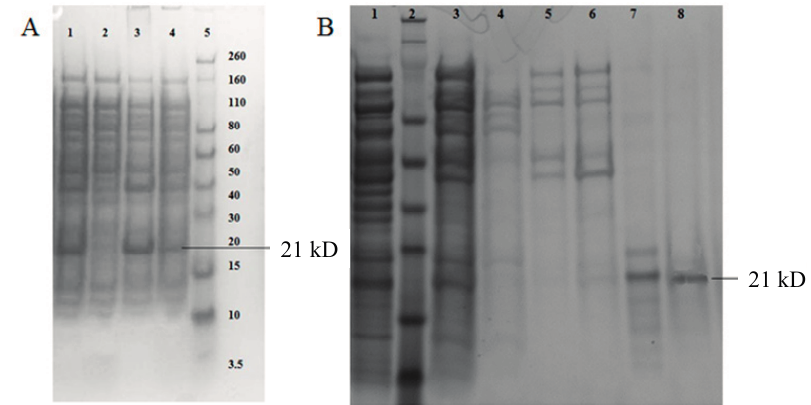
Figure 3. Expression, solubility and purification profile of hybrid HBcAg VLP. ( A ) Expression and solubility profile of hybrid HBcAg VLP protein. Lane 1: total protein